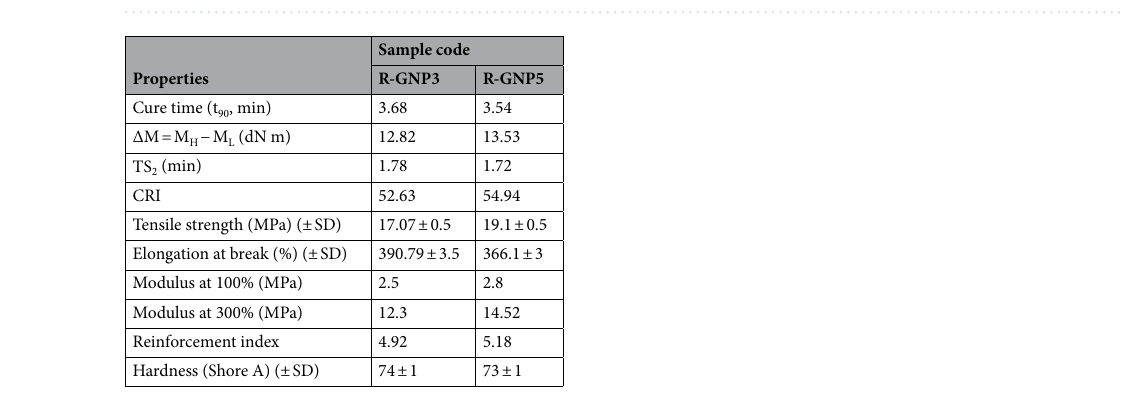
Figure 6. Comparative mechanical properties of the NBR nanocompoites at 3 and 5 wt% loading of nano silica; ( a ) tensile behaviour and ( b ) tensile test results.